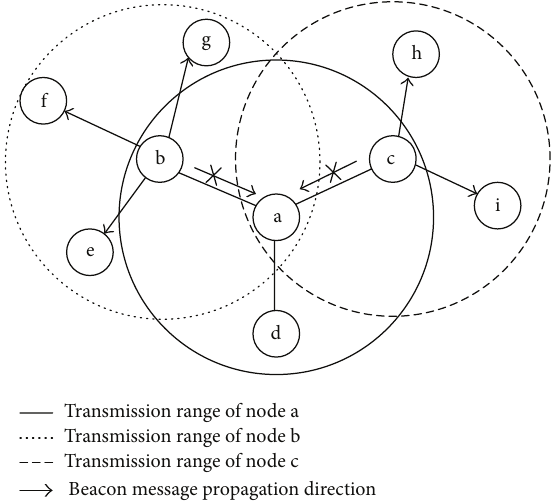
Figure 1: Impact of packet collisions on the accuracy of neighbor discovery and link estimation